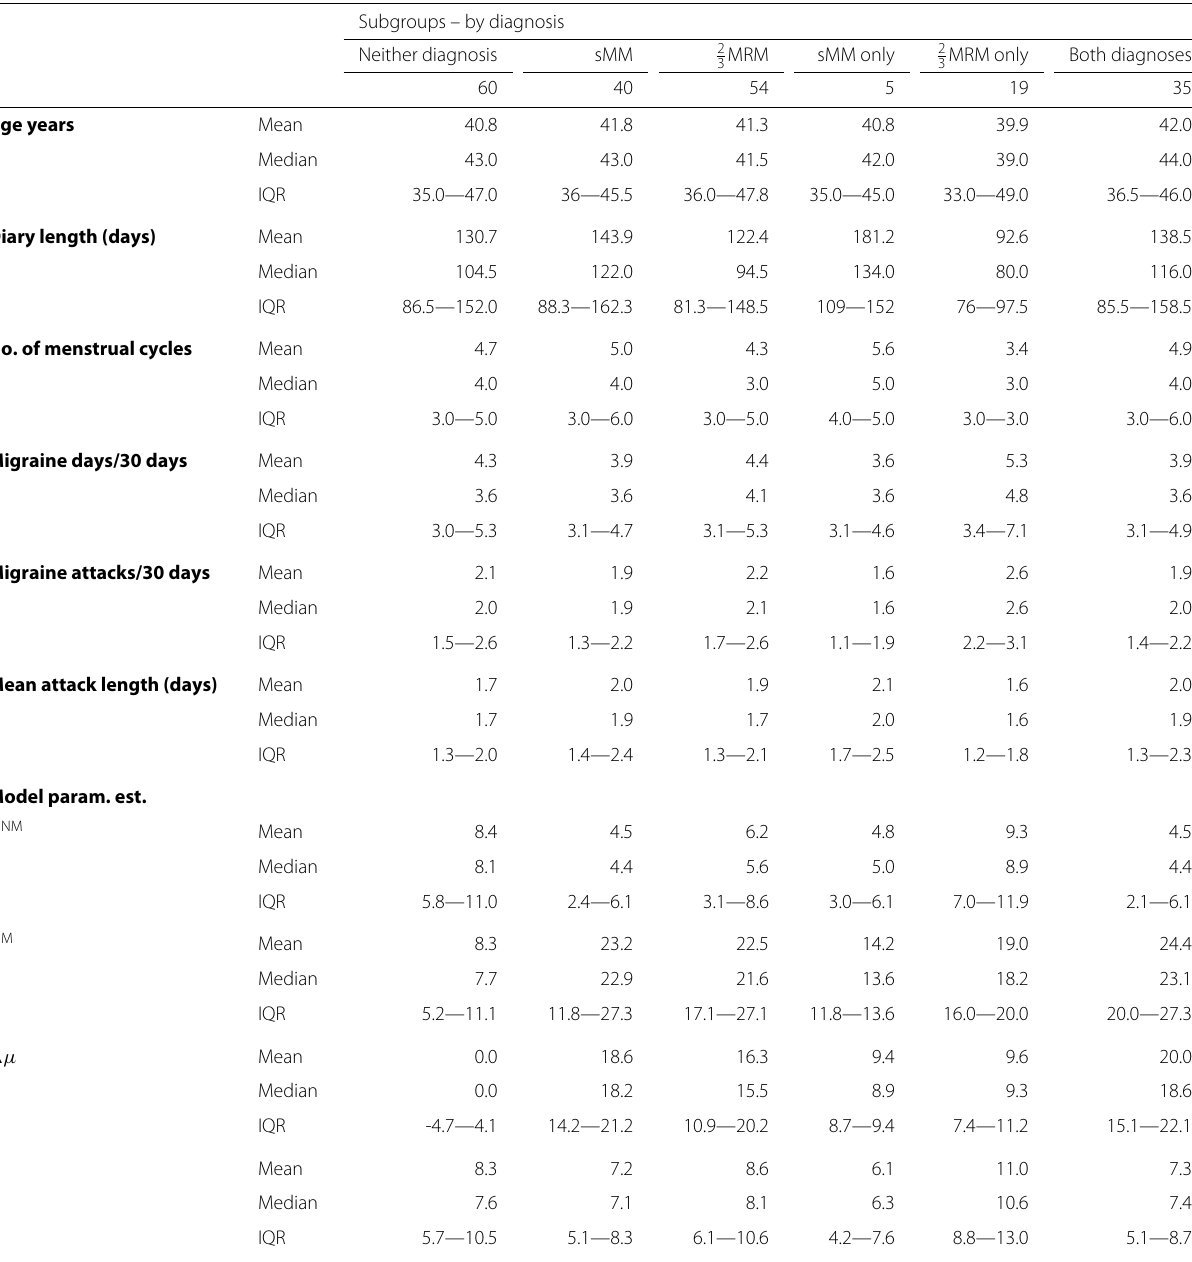
Table 2 Descriptive statistics and estimated Markov chain model parameters for diagnosis-derived subgroups Subgroups – by diagnosis Neither diagnosis sMM 2 3